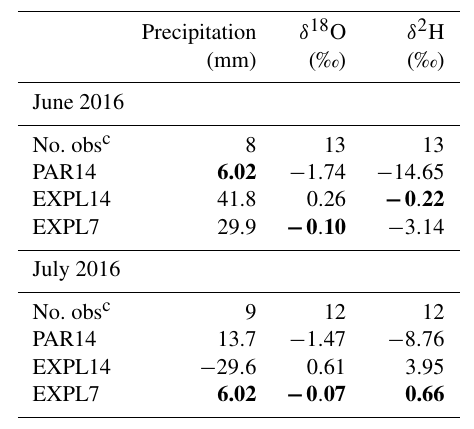
Table 3. ME of precipitation in the three COSMO iso experiments compared with GNIP observations a , b